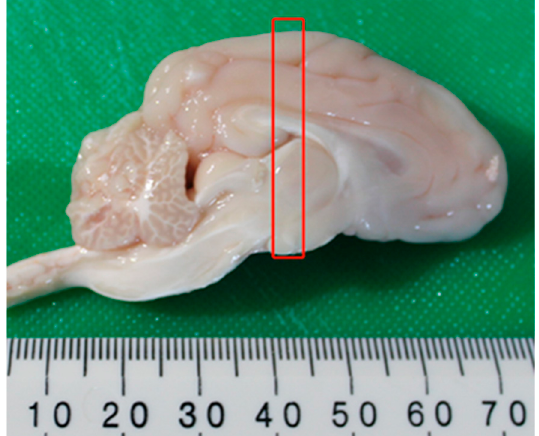
Figure 5. Example of the left cerebral hemisphere of the pig brains recovered in the experiments. The brain was further sliced into 5 mm coronal sections and placed into RNA stabilizing solution. The red box shows the approximate location of the 5 mm section where tissue from the amygdala was obtained.